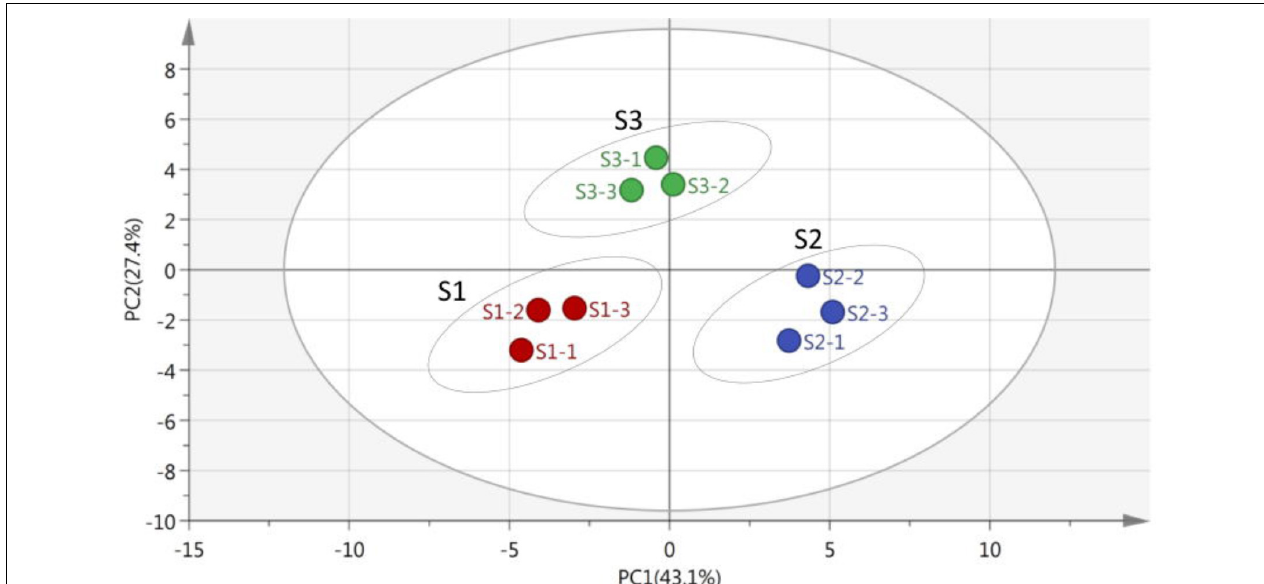
FIGURE 3 | Principal component analysis (PCA) of stored rice microbial communities on the 8th day, the axis of principal component 1 (PC1) described 43.1% and principal component 2 (PC2) described 27.4% of total data variability. The position of the points directly reflected the different metabolic functions of stored rice microbial communities in the principal vector space after dimension reduction (the original data available in Supplementary Table 3).